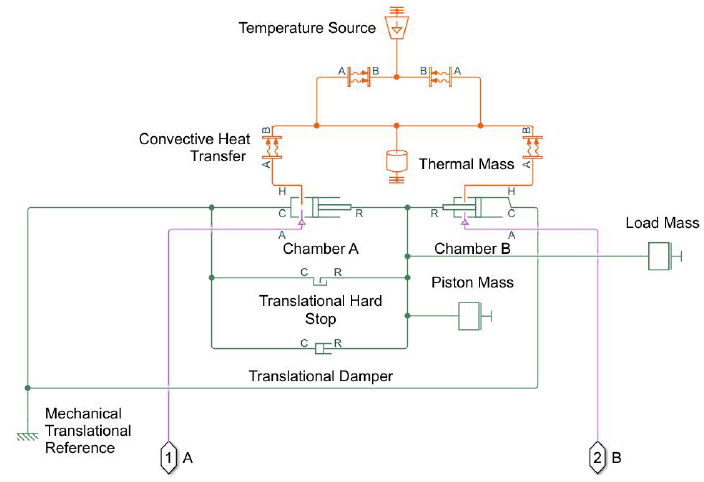
Figure 5. The SimScape model of the cylinder.